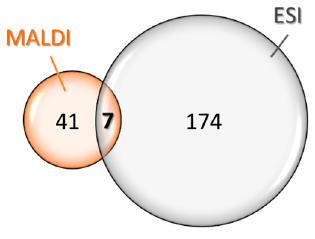
Figure 1. Venn diagram of compounds detected and the mass distribution of glycosylated peptides.